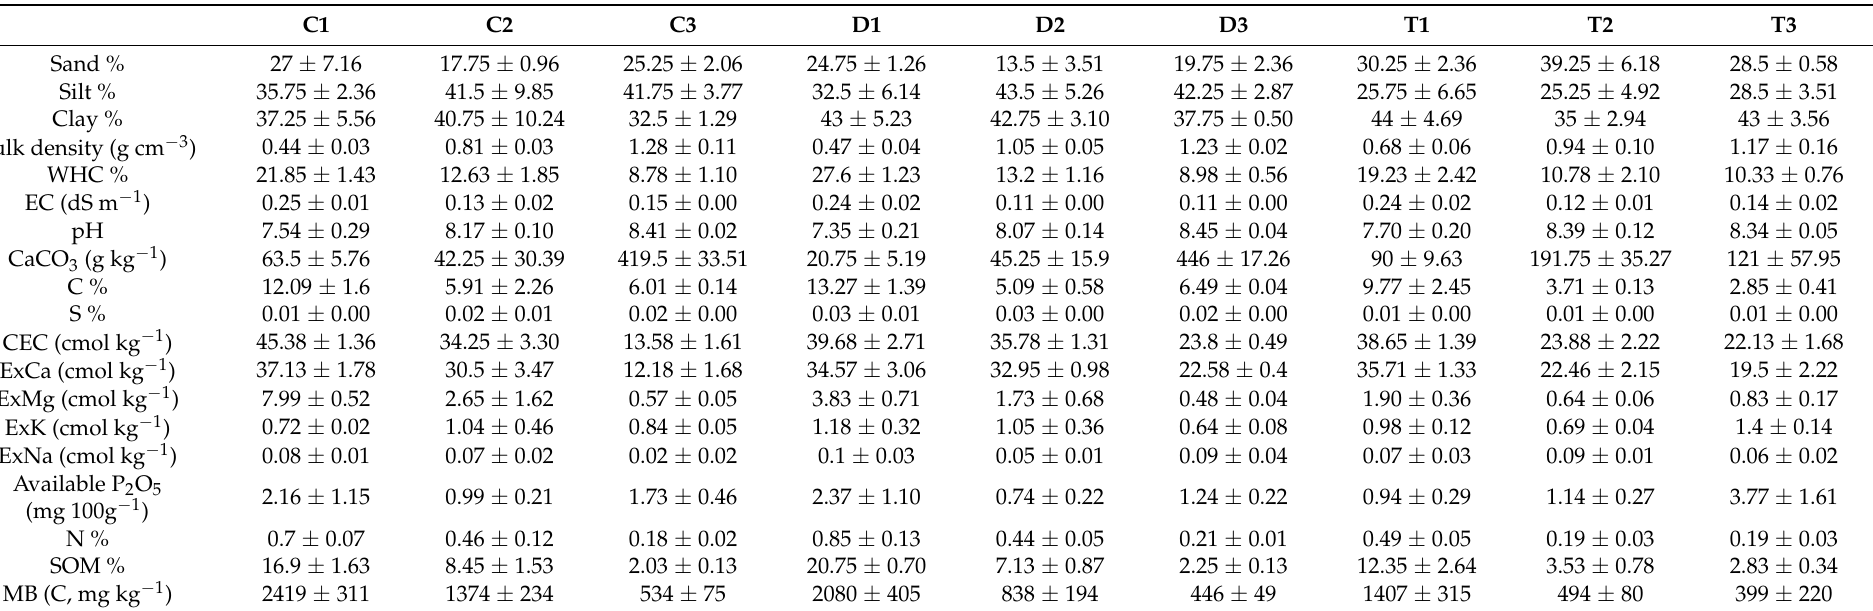
Table 2. Physical, chemical and biological properties of the A horizon of the studied soils. Soils are labelled regarding the parent material (C: Limestone; D: Dolomites; T: Marl and limestone) and soil use (1: Forest; 2: Shrubland; 3: Crops). Data are shown as mean ± standard deviation. WHC: Water Holding Capacity; EC: Electrical Conductivity; CEC: Cation Exchange Capacity; ExCa, Exchangeable calcium, ExMg, Exchangeable magnesium, ExNa, Exchangeable sodium, ExK, Exchangeable potassium, SOM: Soil Organic Matter; MB: Microbial Biomass (in